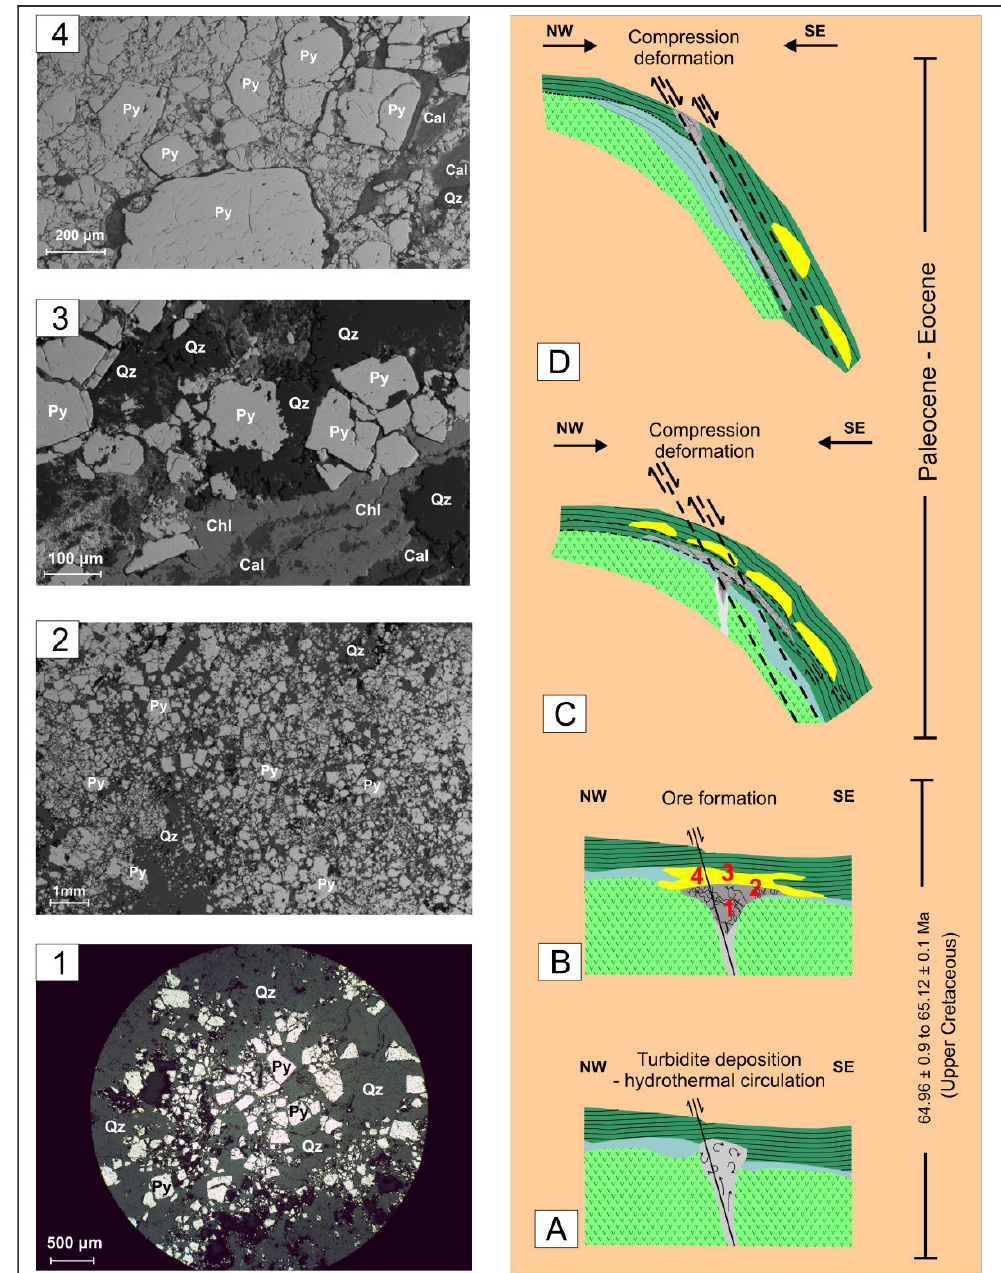
Figure 6. Schematic depiction of the geotectonic evolution of Karakasi VMS (right side ( A – D ), legend as in Figure 5). The Karakasi VMS was formed later and further west (based on contemporary coordinates) relative to Roro VMS, contemporaneously to arkose and turbidite deposition during upper Cretaceous. ( 1 – 4 ) Photomicrographs of Karakasi VMS ore and corresponding position in the Roro VMS. ( 1 ) Disseminated, coarse-grained, euhedral pyrite (Py) and gangue quartz (Qz) from Karakasi stringer ore. ( 2 ) Semi-massive pyritic ore (Py) from the transition zone between the lower stringer ore and the upper massive sulfide orebody. Quartz (Qz) is the predominant gangue phase. ( 3 ) Semi-massive, coarse-grained, euhedral pyrite (Py) with gangue calcite (Cal), chlorite (Chl), and quartz (Qz). The mineralization is hosted in the hanging-wall turbidites. ( 4 ) Massive sulfide ore from Karakasi VMS with abundant pyrite (Py) and gangue calcite (Cal) and quartz (Qz). (Abbreviations after [95]).